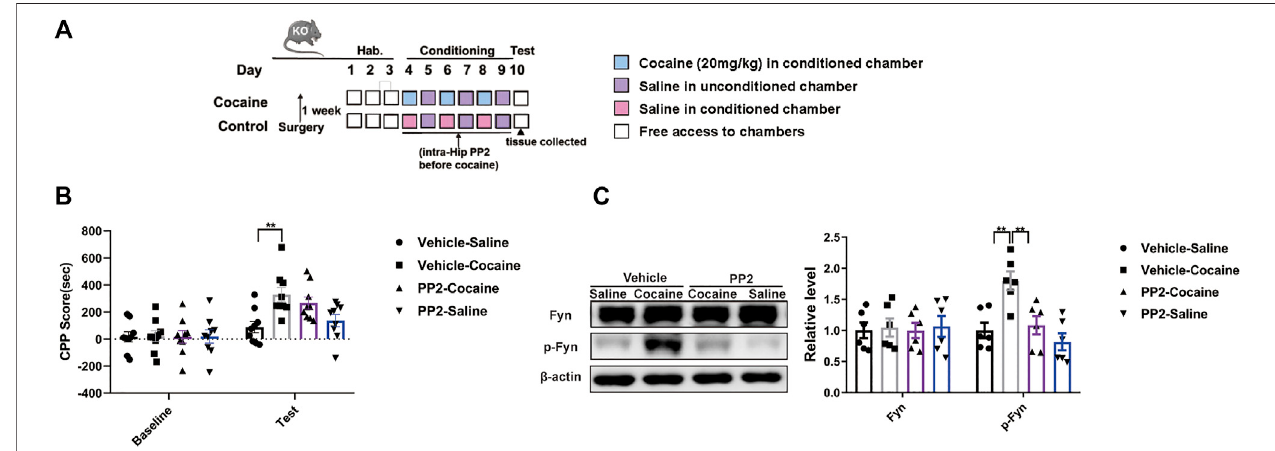
FIGURE5| FyninhibitionweakensthecocaineCPPscoredependingonTauexpression. (A) ExperimentaltimelineforPP2injectioninthecocaineCPPtestofTau- KOmice. (B) InhibitionofFynactivitybyPP2unablesigni fi cantlyattenuatedthecocaineCPPscore( n =9pergroup). (C) ImmunoblottingofFynandphosphorylatedFyn expression in the hippocampus of Tau-KO mice ( n = 6 per group). Data are the means ± SEM, ** p <